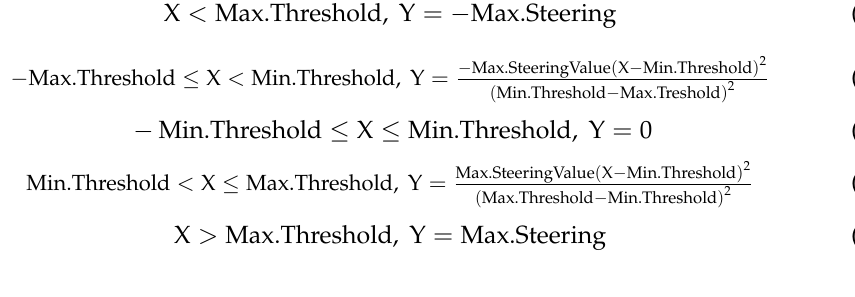
Figure 4. Process diagram of road sign recognition and autonomous driving mode. Equations (3)–(7) show the relationship between the distance differences (X input) measured from the LiDAR sensor and the steering angle (Y output) for the autonomous driving algorithm developed in this study. Here, X represents the value obtained by subtracting the distance to the left wall from the distance to the right wall, and the Y value represents the steering value of the robot. Max. Threshold and Min. Threshold represent the maximum and minimum threshold values at which the steering value changes, respectively. That is, the Max. steering and Min. steering mean the maximum values that can be moved in the left and right directions, respectively; the Max. Threshold and Min. Threshold mean the threshold values at which the maximum and minimum steering values start, respectively. Max. Steering and Min. Steering are the steering values for when the robot rotates, with a value between − 100 and 100, with the left side representing ( − ) and the right side representing (+). While the autonomous driving algorithm uses the distance difference between the left and right walls, the wall-following algorithm controls steering through the distance difference from one side wall [23]. That is, the autonomous driving mode or the wall tracking mode is switched according to the direction indicated by the road mark, and the left and right steering are automatically controlled.